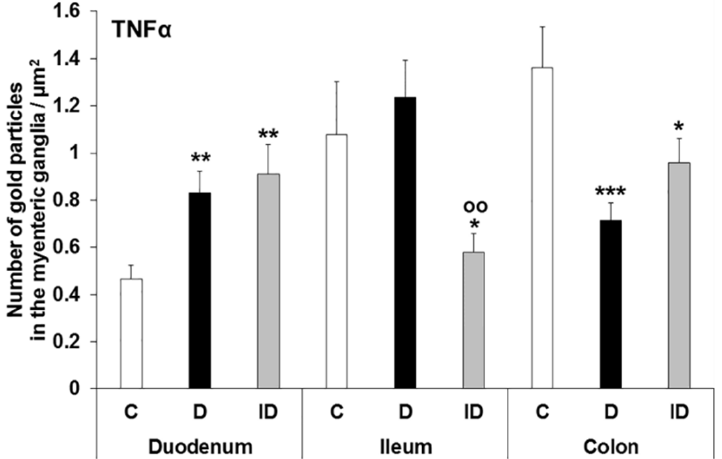
Figure 4. Quantitative evaluation of TNF α -labelling gold particles in the myenteric ganglia from different gut segments of control, diabetic and insulin-treated diabetic rats. The number of TNF α - labelling gold particles increased in the duodenum, decreased in the colon and did not change in the ileum of diabetic rats. The immediate insulin replacement did not prevent the diabetes-related alterations. Data were expressed as means ± SEM. * p < 0.05; ** p < 0.01; *** p < 0.001 (relative to the controls), oo p < 0.01 (between diabetics and insulin-treated diabetics). C–controls; D–diabetics; ID–insulin-treated